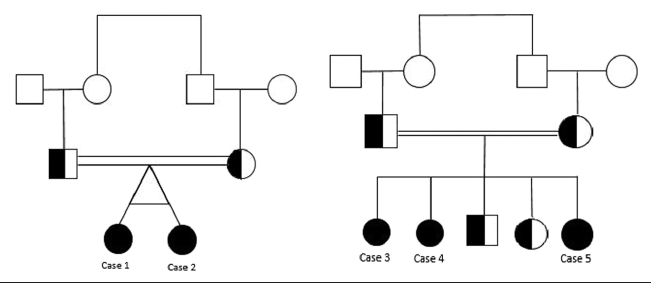
Figure 1. Pedigrees of families with familial hypomagnesemia with hypercalciuria and nephrocalcinosis.